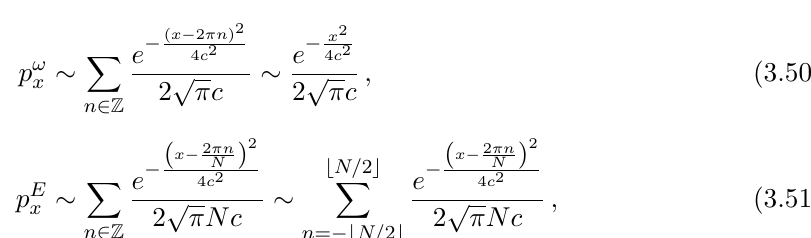
Figure 5. Numerical upper and lower bounds for S A charges: electron charge q =